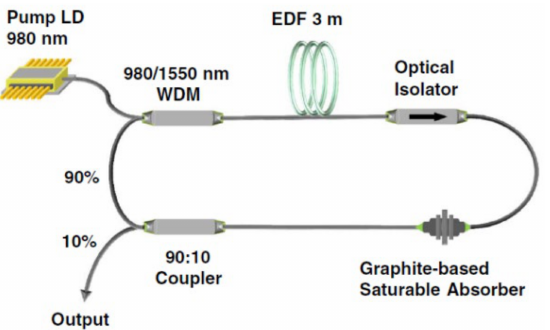
Figure 20. The configuration of a Q-switched fiber laser using a pencil graphite SA. Reprinted with permission from [80].